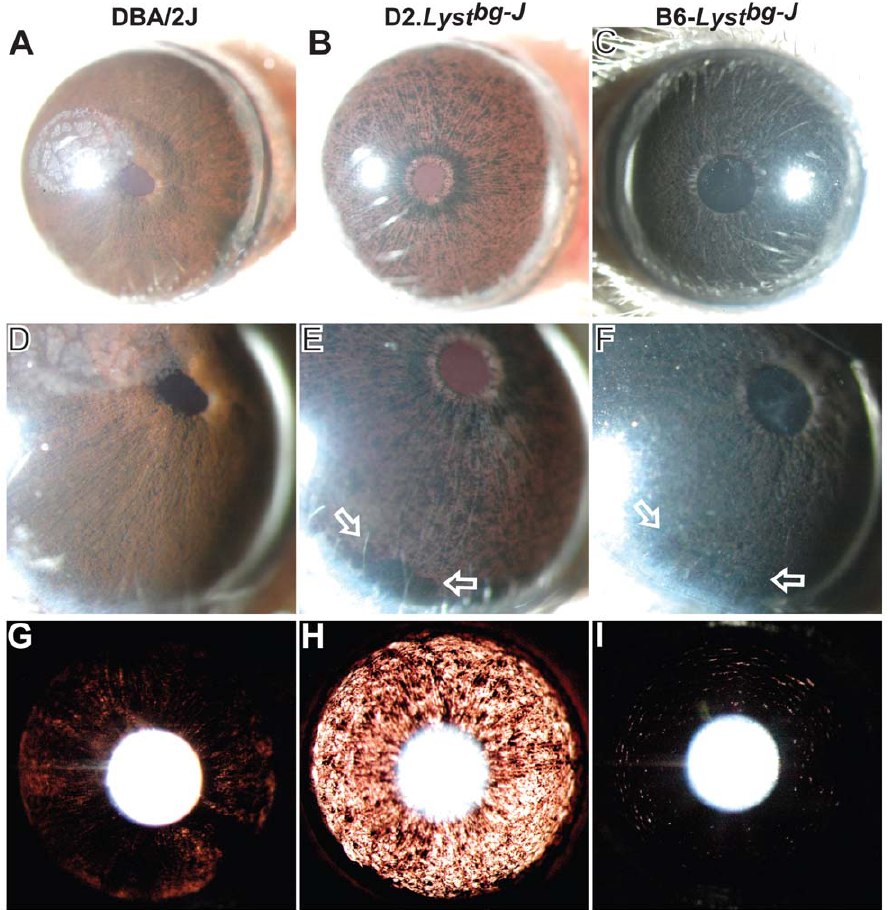
Figure 3. The DBA/2J genetic background enhances Lyst -mutant iris phenotypes. Three different slit-lamp views of DBA/2J ( left column ), D2. Lyst bg-J eyes ( middle column ), and B6- Lyst bg-J ( right column ) eyes, indicating that the DBA/2J genetic background enhances iris phenotypes caused by Lyst mutation. When viewed with broadbeam illumination: (A) 7-month-old DBA/2J eyes exhibit indices of mild iris disease, characterized by early signs of pigment dispersion and the swelling of peripupillary tissue, with corneal calcification typical of this strain also evident; (B) 7-month-old D2. Lyst bg-J eyes exhibit pronounced stromal atrophy and pigment dispersion, with numerous areas of depigmentation allowing light to pass freely through the iris and giving it a red hue; and (C) 9-month-old B6- Lyst bg-J eyes have pronounced stromal atrophy and pigment dispersion, but the iris remains intact overall. When viewed at higher magnification: (D) DBA/2J irides exhibit mild pigment dispersion; (E) D2. Lyst bg-J irides exhibit severe degeneration and have a granular appearance, with large accumulations of dispersed pigment and pigment engulfed macrophages visible inferiorly ( open arrows ); and (F) B6- Lyst bg-J eyes exhibit accumulations of dispersed pigment and pigment-engulfed macrophages that are visible inferiorly, but the iris is less severely degenerated. When viewed with transilluminating illumination: (G) DBA/2J eyes show mild iris transillumination defects, with subtle radial spoke-like tendencies; (H) D2. Lyst bg-J eyes have a severe transillumination defect (evident by the increased amount of red light), indicating a very atrophic iris; and (I) B6- Lyst bg-J eyes exhibit a characteristic pattern of concentric transillumination defects that are far less severe than those in eyes of D2. Lyst bg-J mice. Images in each column are all from the same eye. Magnifications: A–C (25 6 ); D–F (40 6 , with less image reduction); G–I (25 6